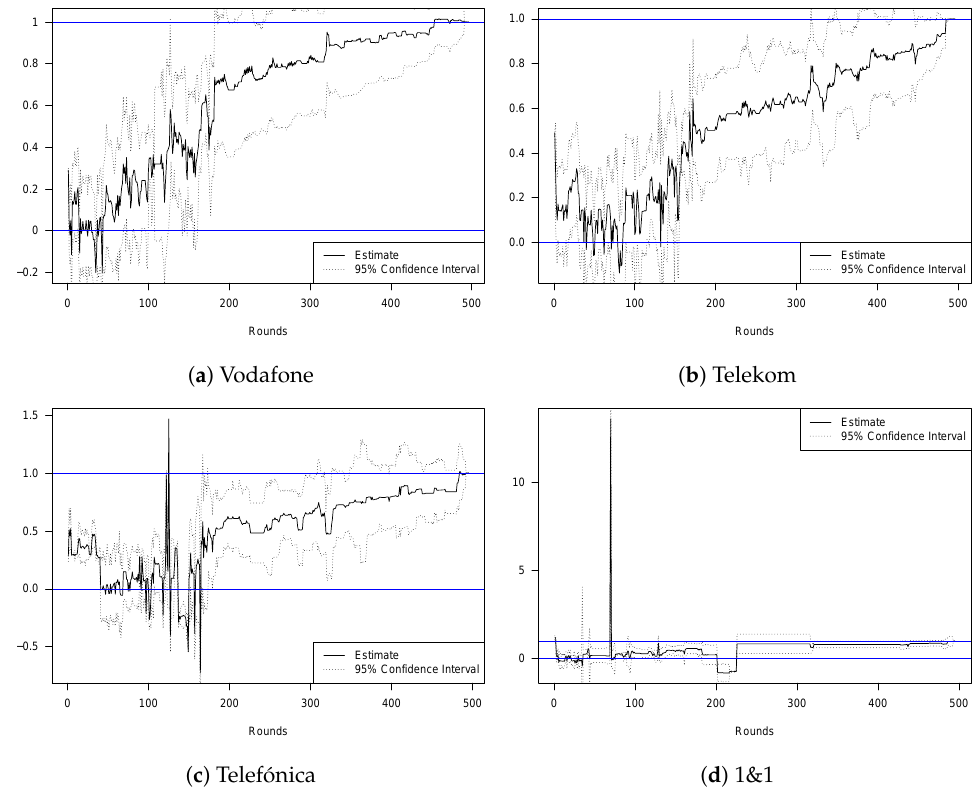
Figure 5. Sample Split by Company . The graph shows the OLS estimate for ˆ β t for each point during the auction for the Vodafone ( a ), Telekom ( b ), Telefónica ( c ), and Drillisch/1&1 ( d ). The two blue lines indicate the noise hypothesis ( β = 0) and the learning hypothesis ( β = 1). The dotted lines represent the 95%-confidence interval based on robust standard